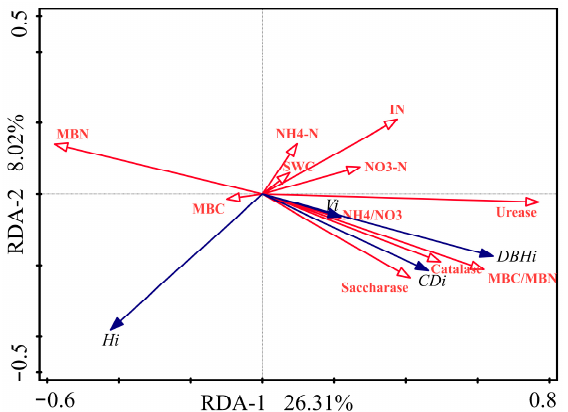
Figure 8. RDA between the poplar growth characteristics (blue arrows) and soil properties (red arrows) under different pruning treatments during four periods. Note: the results of RDA are used to identify the relationships between the poplar growth and soil properties; n (36) = three pruning treatments × four periods × three replications. The percentages on the x -axis and y -axis reflect the response rate of the soil properties to the changes in poplar growth characteristics in different dimensions. NH 4 /NO 3 represents the ratio of soil ammonium nitrogen (NH 4 -N) to nitrate nitrogen (NO 3 -N); the same applies below.